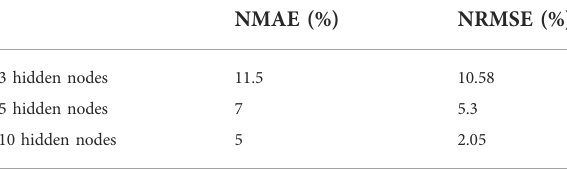
TABLE 3 Evaluation of wind power prediction for 7 days.